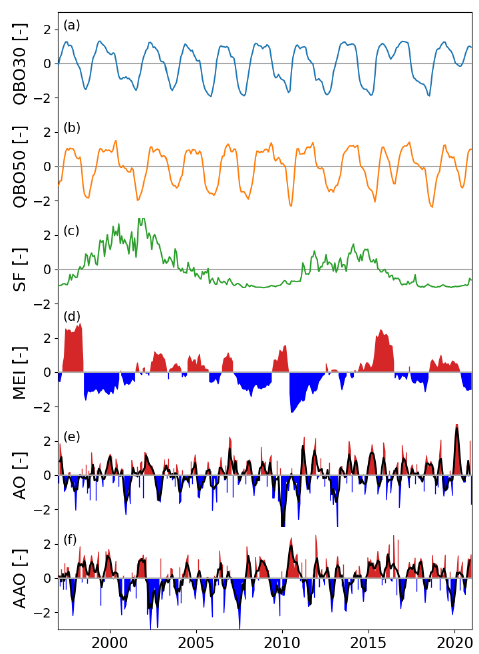
Figure A1. Time series 1997–2020 of all explanatory variables used in the MLR (Eq. 1) normalized to zero mean and unit variance: (a)